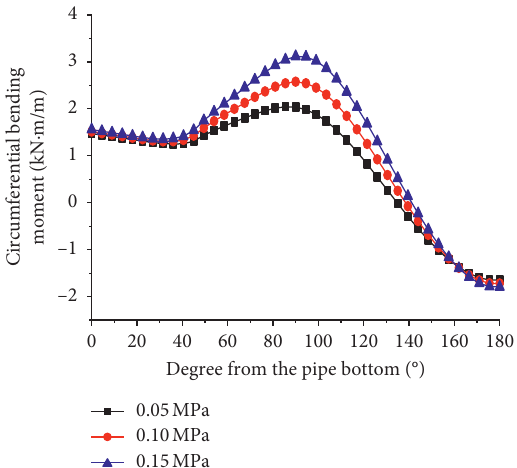
Figure 15: Circumferential bending moments with different loads.